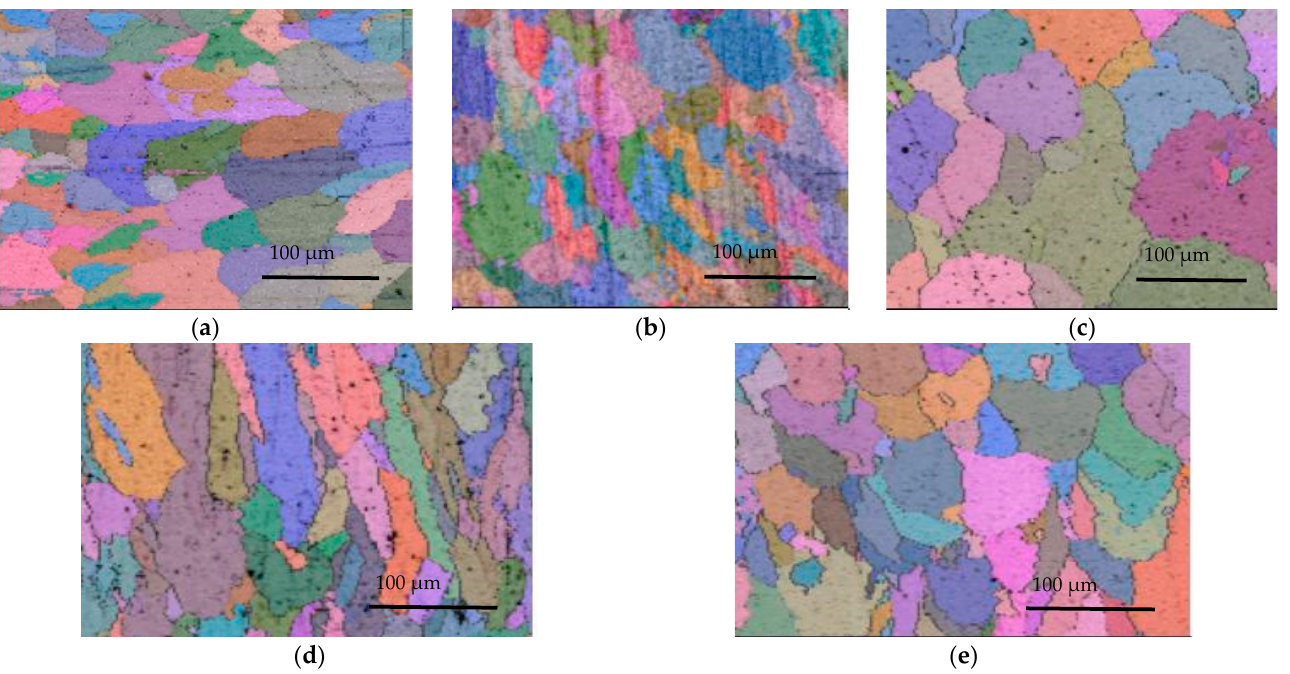
Figure 3. EBSD microstructure of Al-Mg alloyed additive under different process parameters: ( a ) Contrasting sample (90 A, 800 mm/min, 22.5 L/min, 5 min); ( b ) 130 A welding current; ( c ) 400 mm/min welding speed; ( d ) 12.5 L/min gas flow; ( e ) 1 min interlayer residence time.